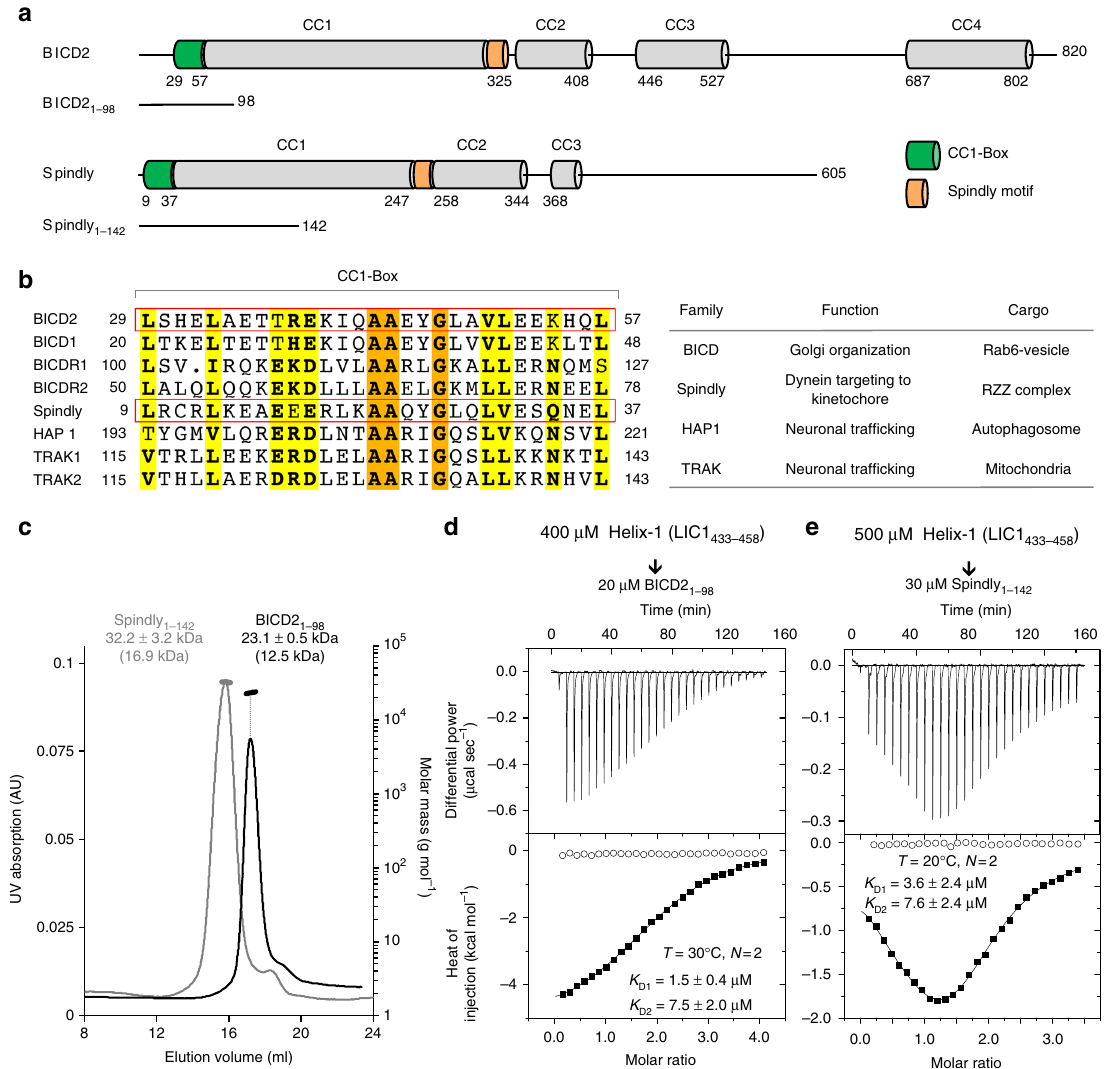
Fig. 4 LIC1 Helix-1 mediates the interaction with CC1-Box-containing effectors. a Domain organization of human BICD2 and Spindly and constructs used in this study. b Sequence alignment of the CC1-Box region (left) of several proteins that link dynein to different cargoes and perform different functions 3,42 – 44 (right). Yellow and orange backgrounds indicate 70% and 100% sequence conservation, respectively. c SEC-MALS analysis of BICD2 1 – 98 (black) and Spindly 1 – 142 (gray). The molar masses determined from light scattering (right y -axis) and the UV absorption at 280 nm (left y -axis) are plotted as a function of the elution volume. The theoretical masses are given in parenthesis. d , e ITC titrations of Helix-1 (LIC1 433 – 458 ) into BICD2 1-98 and Spindly 1 – 142 , respectively. The experimental conditions and fi tting parameters are listed for each titration. Errors correspond to the s.d. of the fi ts. Open symbols correspond to control titrations into